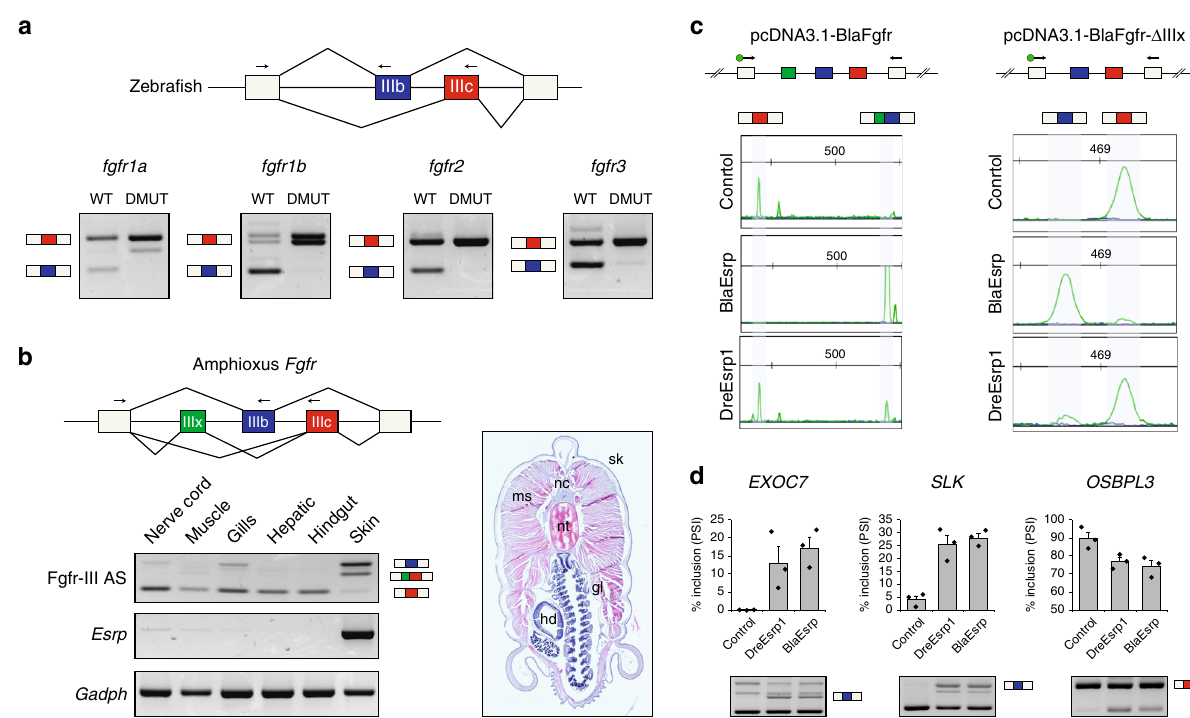
Fig. 6 Fgfr AS is regulated by Esrp genes in vertebrates and amphioxus. a RT-PCR assays showing differential Fgfr exon IIIb and IIIc inclusion in WT versus DMUT 5 d.p.f. zebra fi sh embryos. b RT-PCR assays for Fgfr AS in different amphioxus adult tissues, depicted in a transversal section. nc, nerve cord, ms, muscle, gl, gills, hd, hepatic diverticulum, nt, notochord, sk, skin. Reverse primers were designed in both exons IIIb and IIIc (arrows) and used together in the same PCR reaction. c Top: schematic representation of pcDNA3.1-based minigene constructs containing the genomic region spanning the Fgfr AS event of Branchiostoma lanceolatum , with (pcDNA3.1-BlaFGFR) and without (pcDNA3.1-BlaFGFR Δ IIIx) exon IIIx. Bottom: relative intensity of fl uorescent RT-PCR bands supporting differential inclusion of exons IIIb and IIIc when transfecting the minigenes alone (Control) or together with a plasmid containing either amphioxus or zebra fi sh full-length Esrp transcripts (BlaEsrp and DreEsrp1, respectively). Despite signi fi cant mis-splicing of the minigene in all conditions, only the amphioxus construct was able to induce a dramatic switch toward exon IIIb inclusion. Primers were designed in the neighboring constitutive exons (arrows). d RT-PCR assays for endogenous human AS events in the same control, BlaEsrp or DreEsrp1 transfected 293T cells showing that the amphioxus and zebra fi sh Esrp constructs are able to modulate endogenous Esrp -dependent events in a similar manner. Error bars correspond to standard errors of three biological replicates. Esrp -enhanced isoforms are marked with an isoform